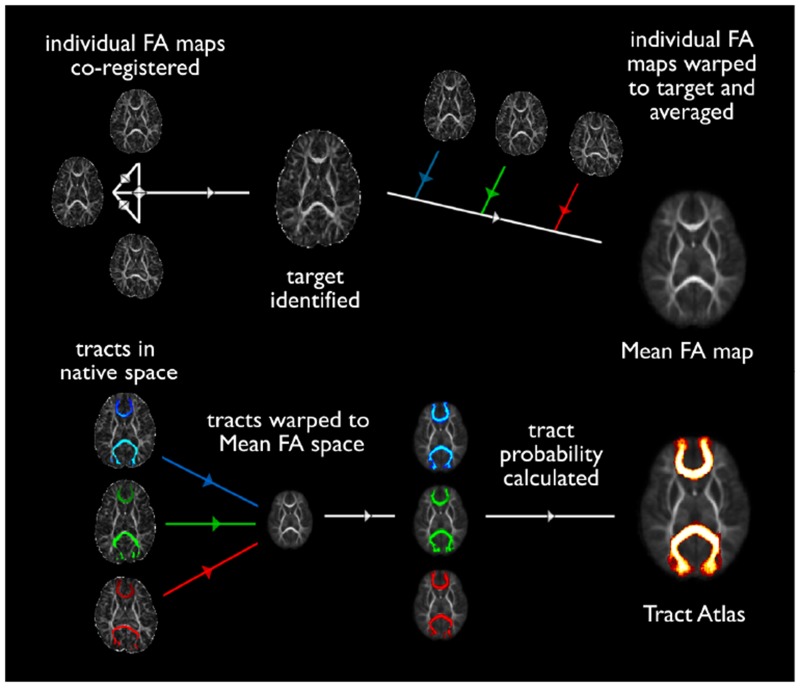
Schematic of registration steps taken to produce probabilistic FA maps (a) and tract atlases (b) in each age group.The target image was identified as that which required the least transformation to register with all others in its age group. Once the individual FA images in each age group were co-registered, FA values at each voxel were averaged together to produce a population-mean FA map for each time point. Tractography distributions from each subject were binarised and coregistered using the same warp matrix from the mean FA atlas. The number of tractography distributions passing through each voxel (i.e. the overlap across subjects) was then computed to represent the degree of conservation each tract across the population (Tract Atlas).